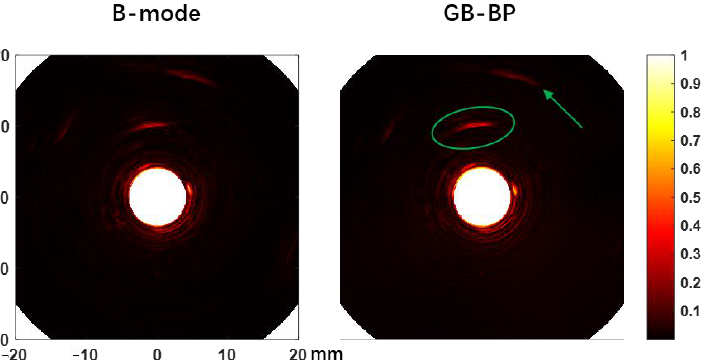
Figure 8. The rabbit rectal photoacoustic endoscopy images after ICG injection obtained by the B-mode method and GB-BP algorithm. Coordinate axis units are millimeters.